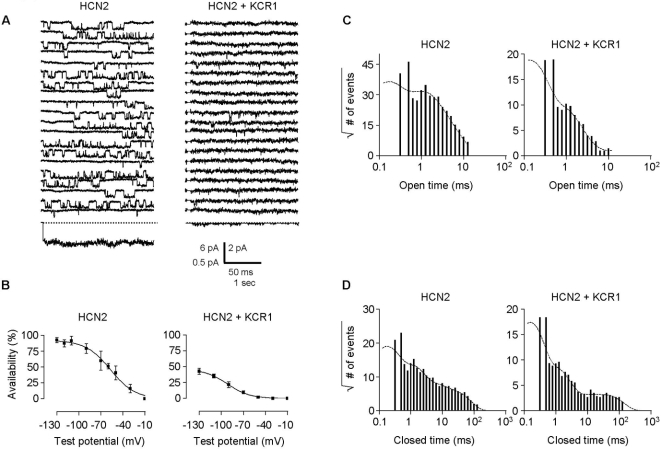
Effect of KCR1 on single recombinant HCN2 channel gating in one-channel patches.(A) Comparison of single recombinant HCN2 channels transfected in CHO cells alone (left) and with KCR1 (right). Middle, 20 consecutive single traces of each channel without and with KCR1. Single channels were hyperpolarized at continuous pulse mode for a total duration of 3 s (20×150 ms sweeps), with a holding potential of −35 mV and a test potential of −90 mV. Bottom, ensemble average current of one consecutive sweep of 3 s pulse duration. Scale bars, 50 ms, 6 pA (unitary current traces) for HCN2 alone (left) and 2 pA when co-transfected with KCR1 (right), or 1 s, 0.5 pA (ensemble average current) for HCN2 and HCN2+KCR1. (B) KCR1 significantly shifted IHCN2 activation to more negative potentials. Channel activation was measured by the parameter availability, plotted against the test potential and then determined by using the Boltzmann function. For data see text. (C) Open-time histograms: KCR1 reduced the number of HCN2 open states. Number of open events (square root) were plotted against the logarithmically binned open time durations for HCN2 alone and HCN2+KCR1 (pooled one- and multi [n≤3]-channel experiments). (D) Closed-time histograms: KCR1 did not affect the number of HCN2 closed states. Number of closed events (square root) were plotted against the logarithmically binned closed time durations for HCN2 alone and HCN2+KCR1 (pooled one-channel experiments only).